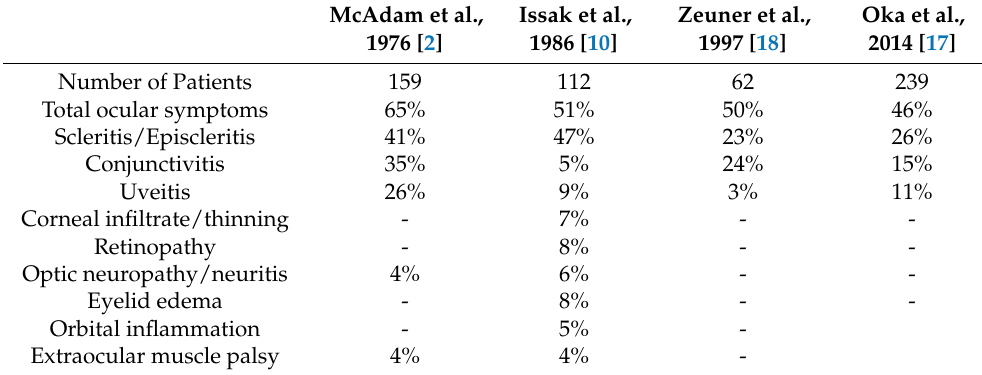
Table 3. Incidence of major ocular manifestations in four large case series.